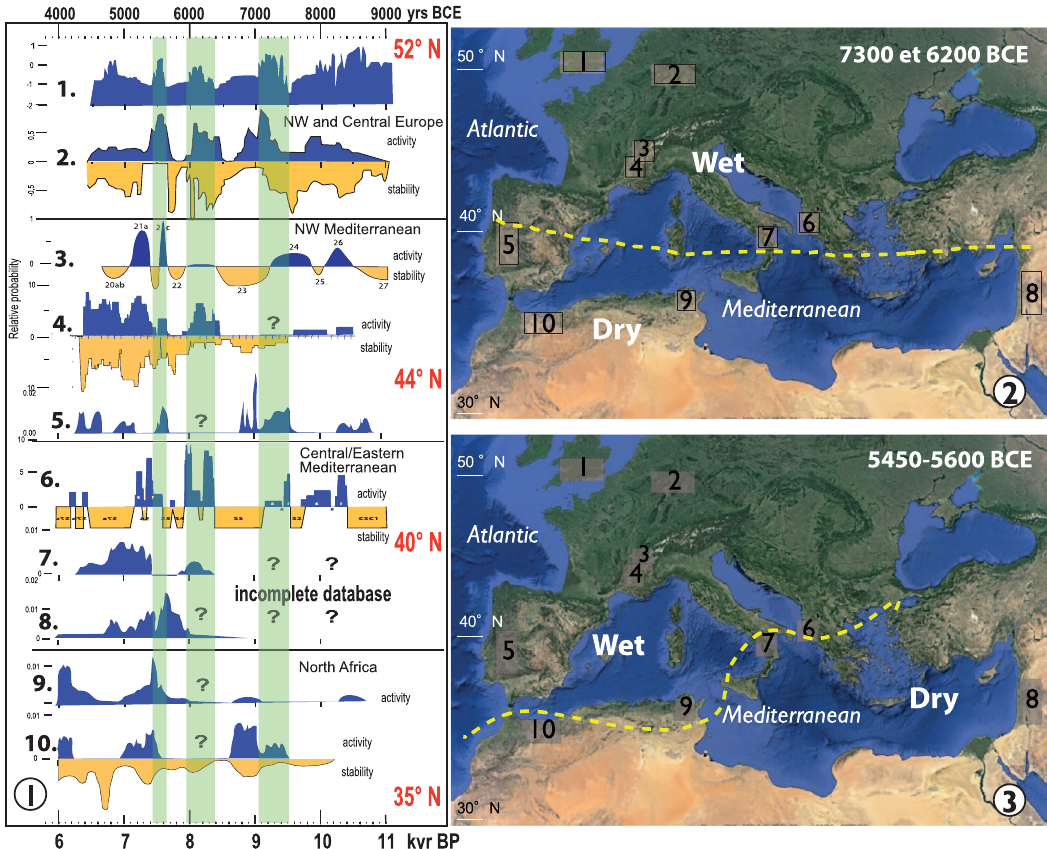
Figure 2: ( 1 ) CPDFs of 14 C dates associated with major river fl ooding ( blue ) and fl oodplain pedogenesis ( yellow ) episodes from 52° to 35° N in NW Europe and Mediterranean regions between 9000 and 4000 BCE. ( 1 ) CPDF of low lands unglaciated river catchment ( Macklin, Jones, & Lewin, 2010 ) , ( 2 ) CPDF of German rivers and soils activity ( Ho ff mann et al., 2009 ) , ( 3 ) CPDF of upper - Rhone rivers and soils activity ( Berger, Salvador, Franc, Verot - Bourrely, & Bravard, 2008 ) , ( 4 ) CPDF of Mid - Rhone rivers and soils activity ( Berger, 2015 ) , ( 5 ) CPDF activity of Western Iberian rivers ( Benito et al., 2015 ) , ( 6 ) CPDF of Sidari erosion and soils activity ( Berger et al., 2016 ) , ( 7 ) CPDF of river activity of Southern Italy ( Benito et al., 2015 ) , ( 8 ) CPDF of river activity of Eastern Mediterranean ( Benito et al., 2015 ) , ( 9 ) CPDF activity of Tunisian rivers ( Benito et al., 2015; Zielhofer & Faust, 2008 ) , and ( 10 ) CPDF activity of Moroccan rivers ( Benito et al., 2015 ) . The three vertical green bands identify three main hydroclimatic variations ( RCC ) , detected in most of the studied catchments. Question marks indicate their absence in the river series. ( 2 ) Map of wet and dry regions around 7300 and 6200 BCE. ( 3 ) Map of wet and dry regions around 5450 – 5600 BCE. The yellow dashed lines show the likely bioclimatic boundaries on either side of the Mediterranean. Around 7300 and 6200 BCE, a clear deli - mitation of hydroclimatic functioning separates the north and south of the Mediterranean basin at 40° N. Around 5500 BCE, the Mediterranean basin appears to be separated into two compartments ( western and eastern ) by a boundary running from northern Tunisia to southern Italy and then to northern Greece. Here, we fi nd the see - saw e ff ect of Figure 1, well calibrated by current climate